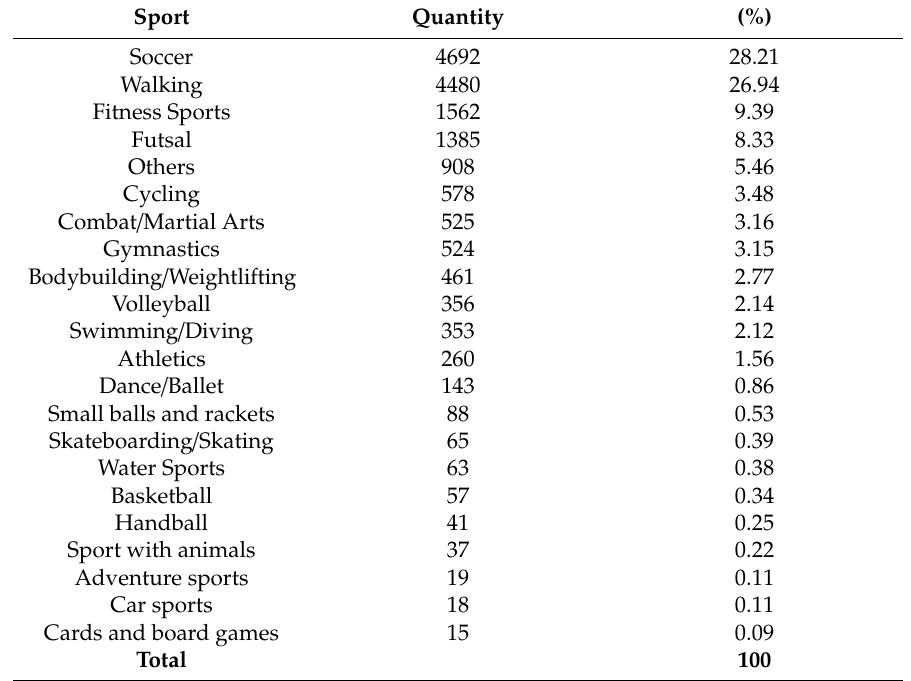
Table 5. Main sports practiced (%).